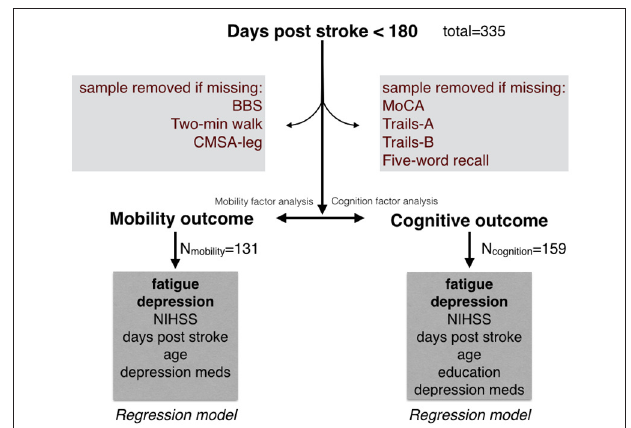
FIGURE 1 | Initial sample from the Rehab Affiliates study, and the sub-groups that were formed to test hypotheses. Only complete records were considered in the regression models. Factor analysis was performed to generate a single composite score for mobility, and similarly a single composite score for